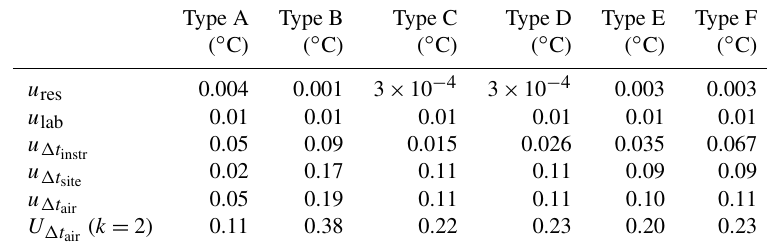
Table 5. Contributions to the uncertainty budget evaluated in the laboratory and in-field characterisation.